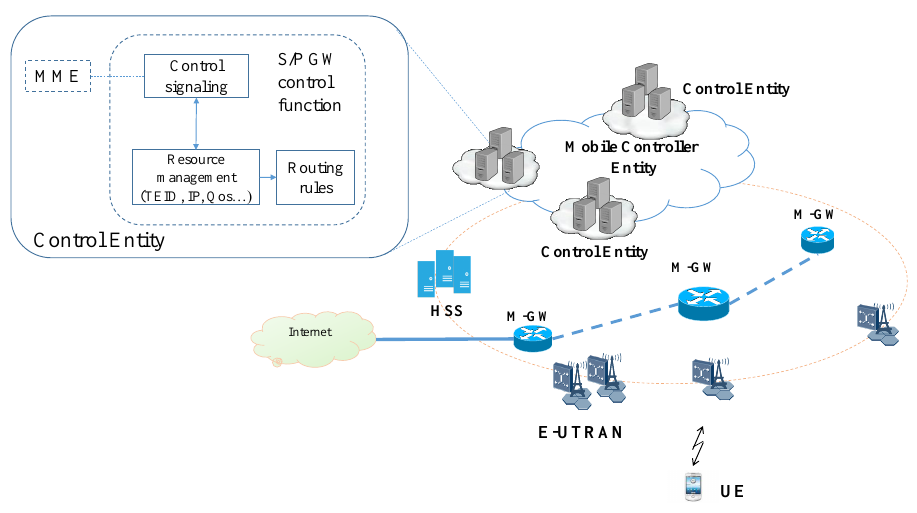
Figure 2. Proposed partially distributed packet core for 5G